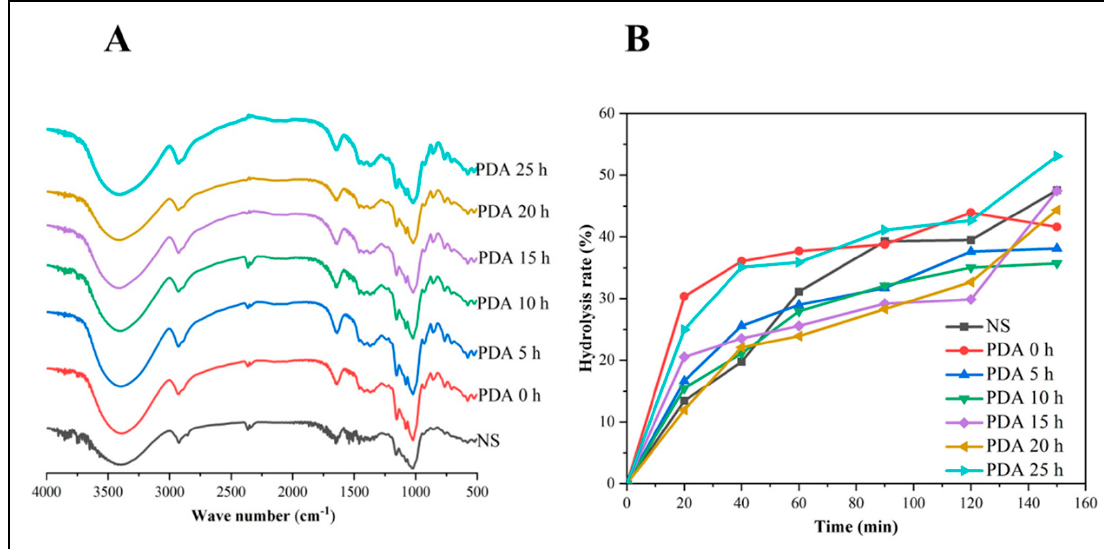
Figure 5. FT − IR spectra ( A ) and in vitro hydrolysis curves ( B ) of native and debranched starch samples. NS, PDA 0 h, PDA 5 h, PDA 10 h, PDA 15 h, PDA 20 h, and PDA 25 h indicate native starch and pullulanase debranching in different treatment times combined with autoclaving starch.